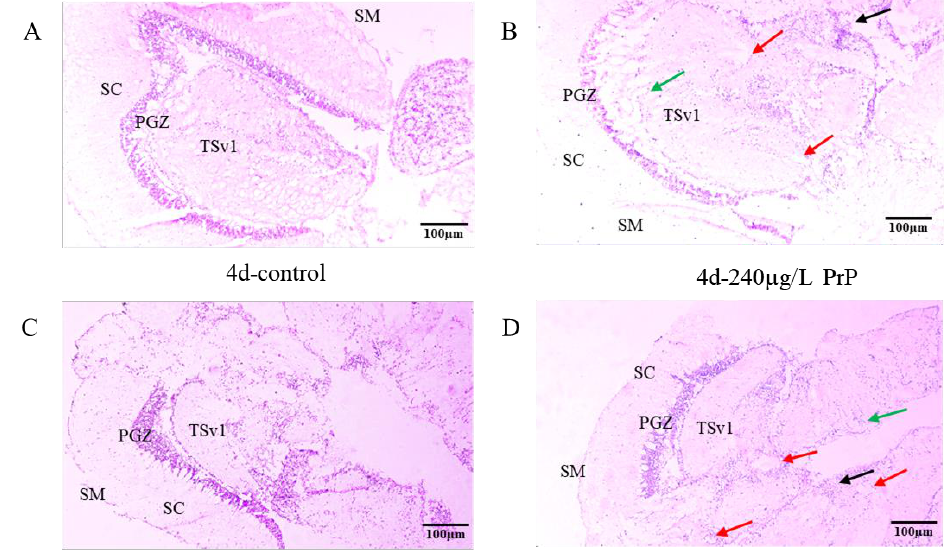
Table 1. Histopathological effects in the brain, liver and testes of male mosquitofish suffering from included 10 µ L of PowerUp SYBR Green Master Mix, 2 µ L of cDNA template, 1 µ L of 0, 0.15, 6, 240 μg/L PrP for 4d and 32d. upstream and downstream primers (10 µ mol/L) and 6 µ L of ultrapure water. The reaction procedure was set as 95 ◦ C, 30 s; 40 cycles (95 ◦ C, 5 s; 55 ◦ C, 30 s); melting curves: 95 ◦ C, 10 s; 65 ◦ C, 5 s; 95 ◦ C, 0.50 s. The mRNA expression of the target genes were analyzed using ∆∆ Ct the 2 - method [54].